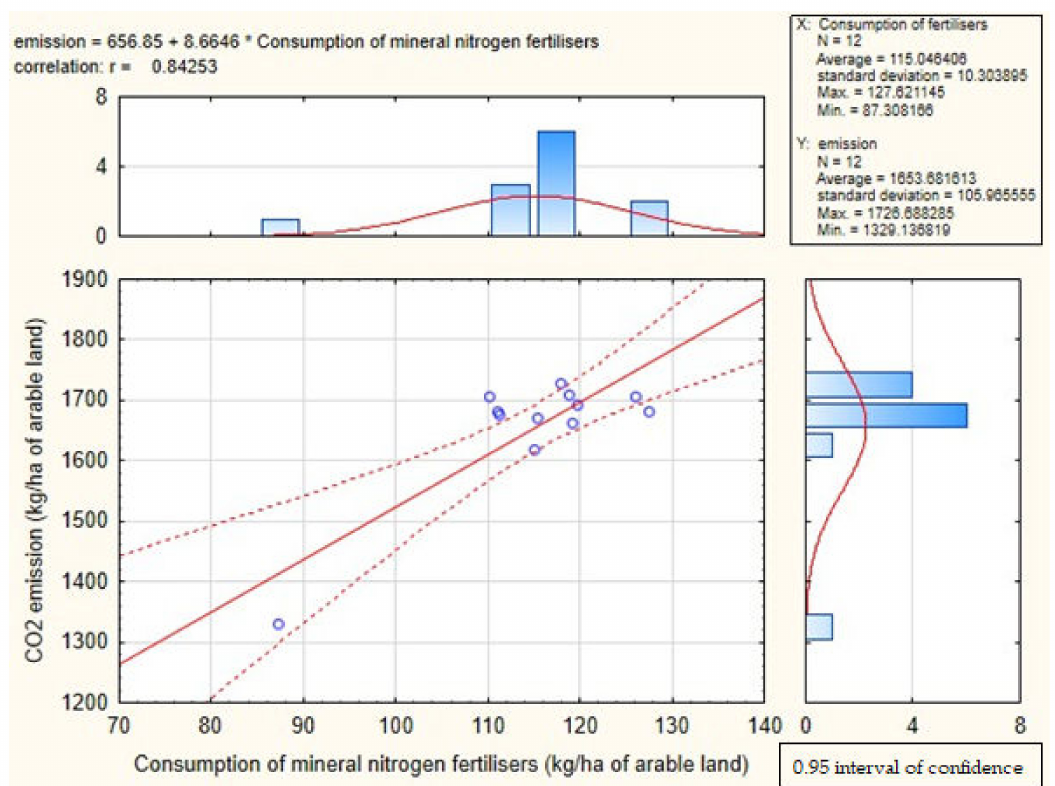
Figure A8. Results of correlations analysis: France. Source: own calculation based on Eurostat. Note: purple dot: observation, red solid line: linear function, red dashed lines: 95% interval of